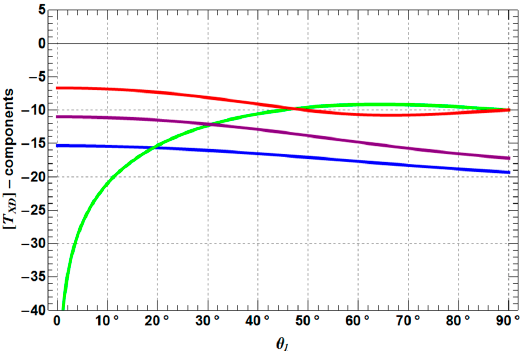
Figure 3. Sensitivity of coherency matrix elements T XD11 (blue), T XD12 (purple), T XD22 (red) and T XD33 (green) (dB) with roughness angle θ 1 ( ε s = 20, ε t = 10, ω l = 50°, L SXD = 1, ϕ = 0°).